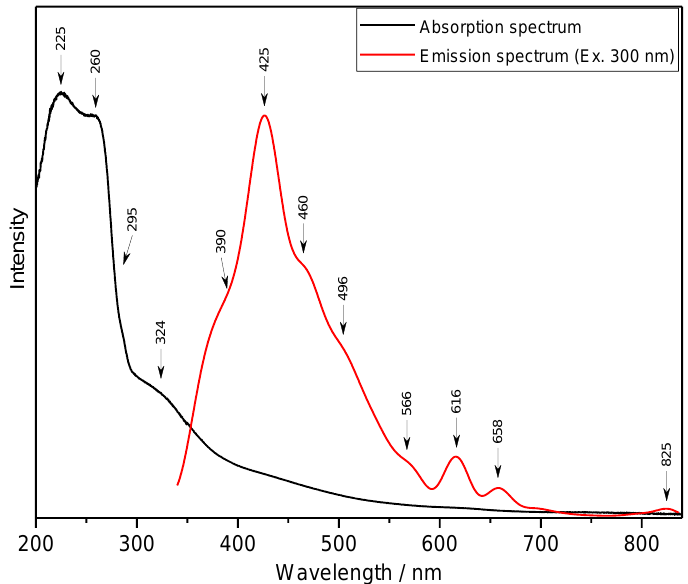
Figure 5. Absorption and emission spectra of loganic acid.